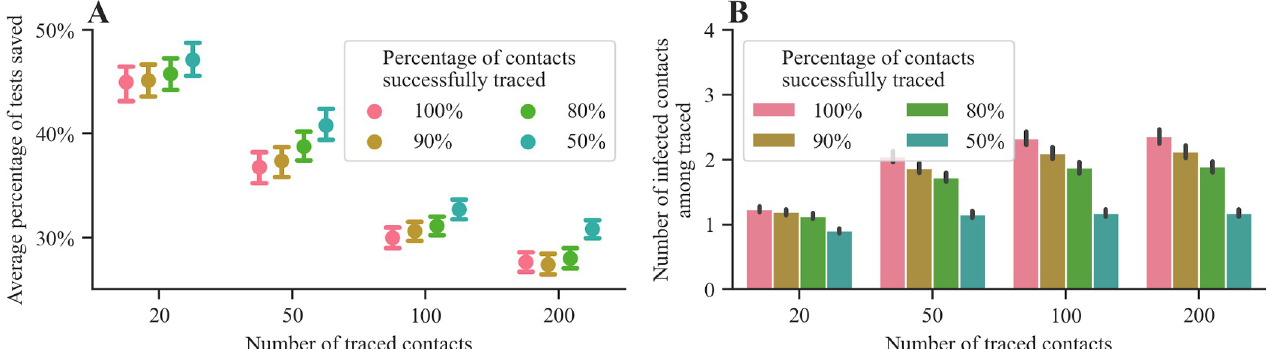
Fig 5. Performance of our method and Dorfman’s method under incomplete contact tracing. Panel ( A ) shows the average percentage of tests saved by j and the percentage of contacts who were using our method instead of Dorfman’s under various values of the number of traced contacts N ¼ j N traced j . Panel ( B ) shows the number of infected contacts in N . In both panels, error bars represent 95% confidence intervals. successfully traced, i.e., N = j N total traced Here, we first sample the number of positive infections from a truncated negative binomial distribution with reproductive number R = 2.5 and dispersion parameter k = 0.1 for a set of contacts N and then, we compute pool sizes and evaluate both methods based on a random subset of size N. For each total combination of method and parameter values, the averages in all panels are estimated using 10,000 samples.